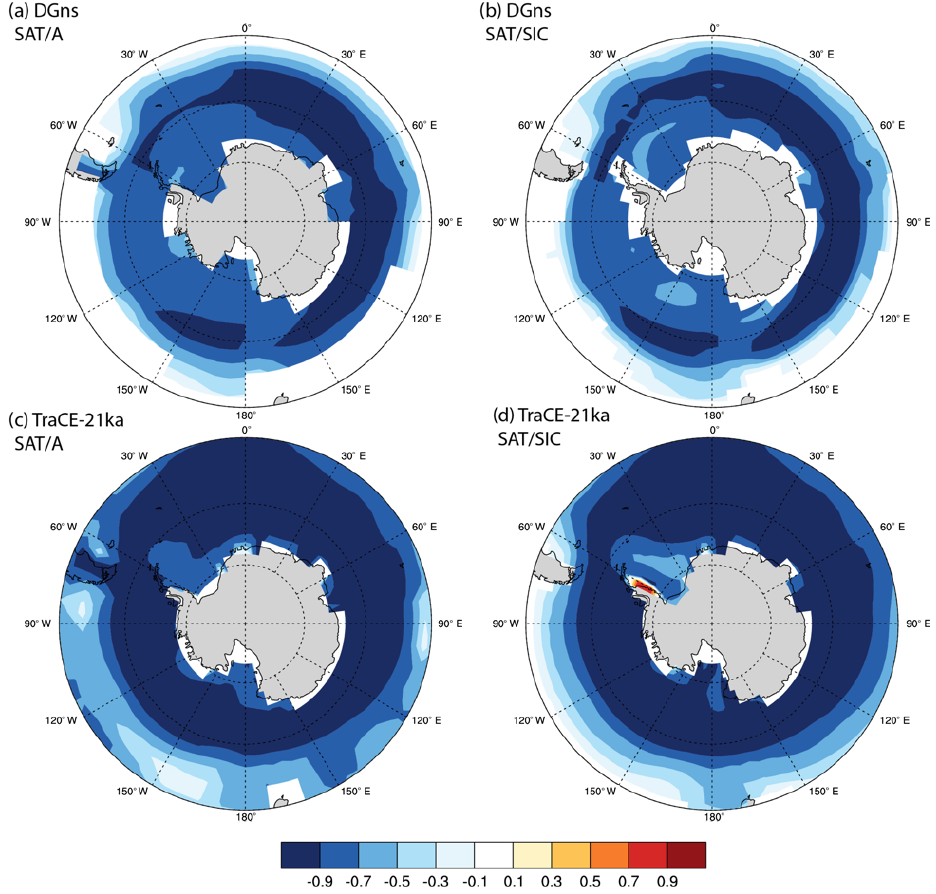
Figure 11. Spatial Pearson linear cross-correlation coefficients ( r ) between decadal surface air temperature (SAT, ◦ C), surface albedo ( A ), and sea ice coverage (SIC, %) for (a, b) DG ns and (c, d) TraCE-21ka (maximum latitude of 45 ◦ S). Dotted lines indicate latitude (intervals of 15 ◦ ) and longitude (intervals of 30 ◦ ). DG ns SAT was regridded to the same grid as DG ns SIC using bilinear interpolation in panel (b)